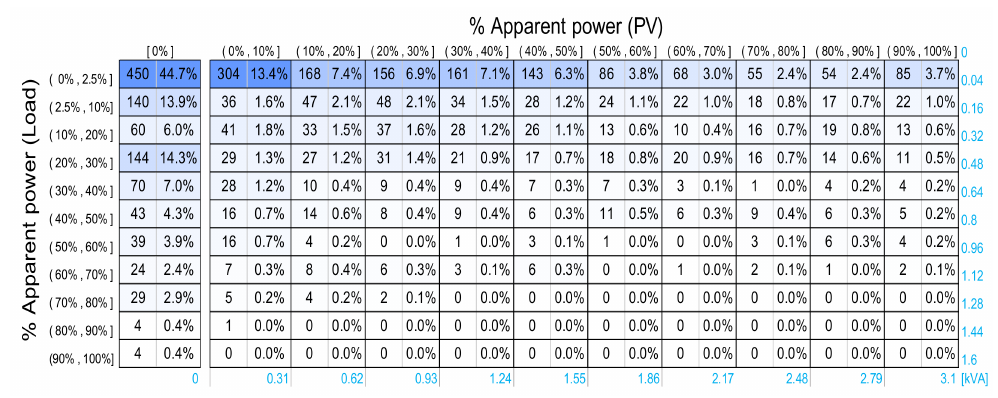
Figure 12. Frequency matrix of Phase B.